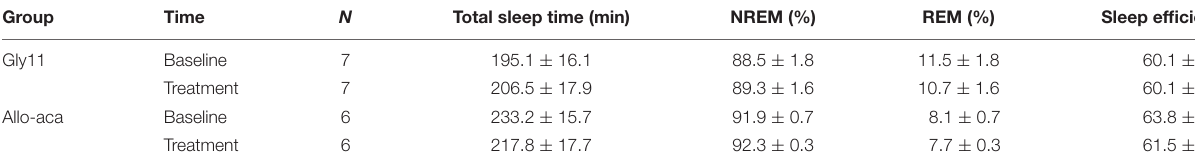
TABLE 1 | Sleep architecture in NZO mice at baseline and after the treatment with leptin receptor blocker Allo-aca or control peptide Gly11.